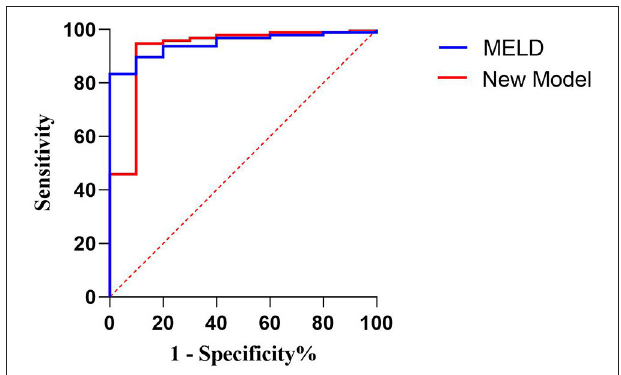
FIGURE 2 | Receiver operating characteristic curve of the model for end-stage liver disease scoring system and the new model for predicting maternal death.